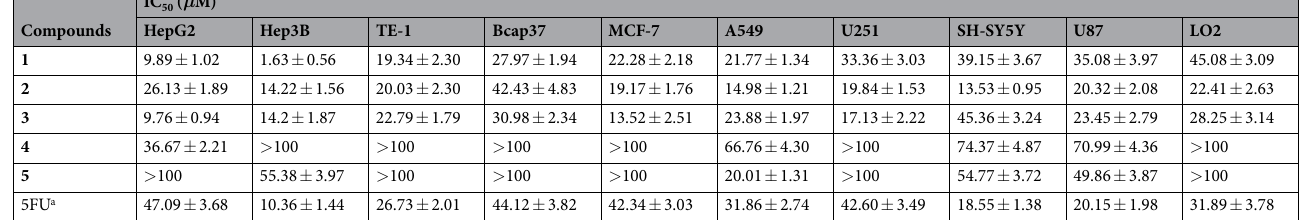
Table 2. Cytotoxic activities of compounds 1 – 5 . a 5FU was tested as positive